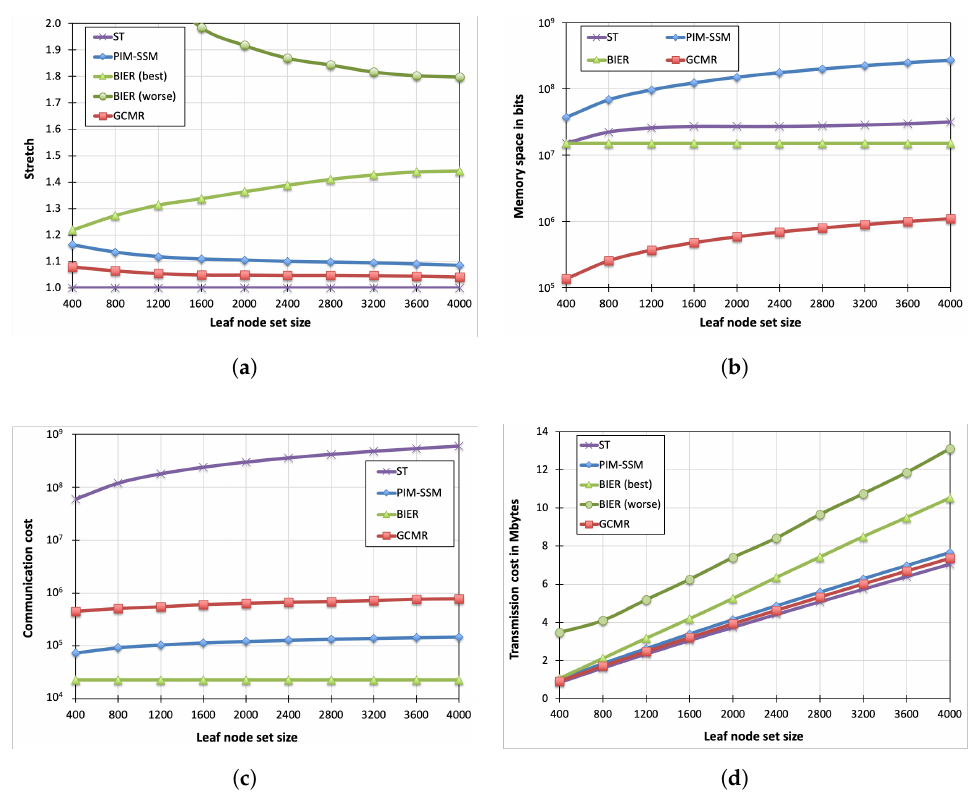
Figure 8. Comparison between GCMR, ST, PIM-SSM and BIER in the simulation platform for the 46k map: ( a ) stretch; ( b ) memory size in bits; ( c ) communication cost in number of messages; ( d ) transmission cost in